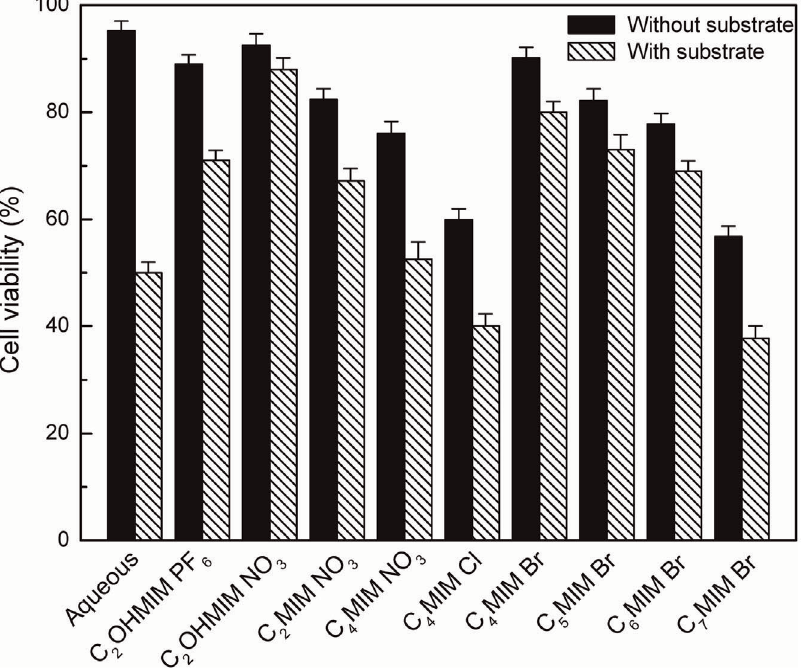
Figure 2. Cell viability of Candidaparapsilosis . Conditions: Cells were exposed to co-solvent systems comprising 10% (v/v) of various ILs and TEA- HCl buffer (100 mmol/L, pH 5.0), with and without substrate (3.0 mmol/L TMSB). doi:10.1371/journal.pone.0037641.g002 PLoS ONE |